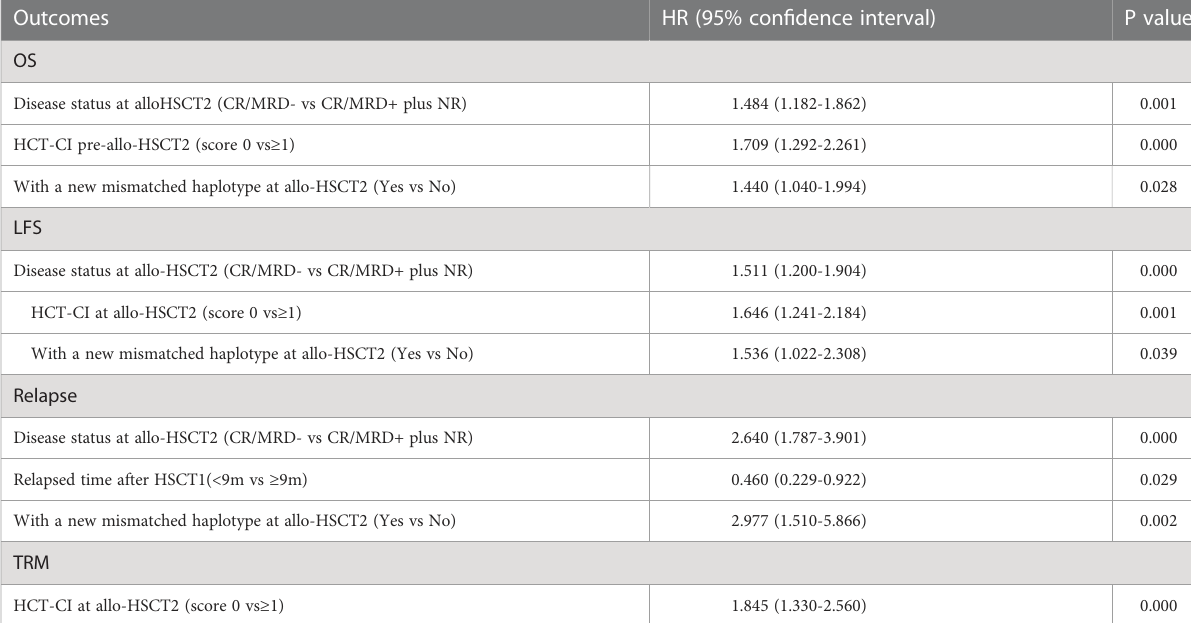
TABLE 4 Multivariate analysis of pre-alloHSCT2 variables associated with outcomes.